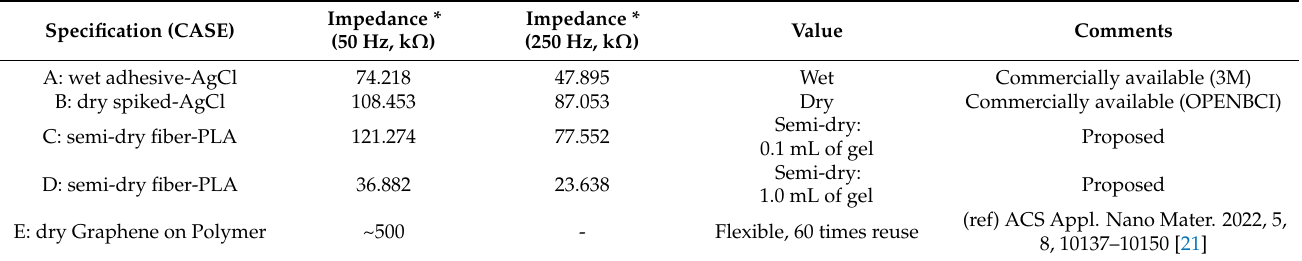
Figure 2. Scanning electron microscope (SEM) images of the porous electrospun fiber network at various magnifications. ( a ) 60×, ( b ) 120×, ( c ) 200×, and ( d ) 400×. Table 1. The impedance comparison of manufactured samples with other